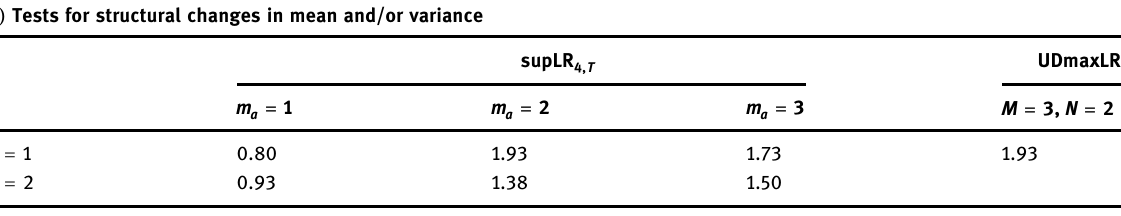
Table 2: Tests for structural changes in mean and variance from Perron et al. ( 2020 ) : Australian real house prices, rhp ( a ) Tests for structural changes in mean and/or